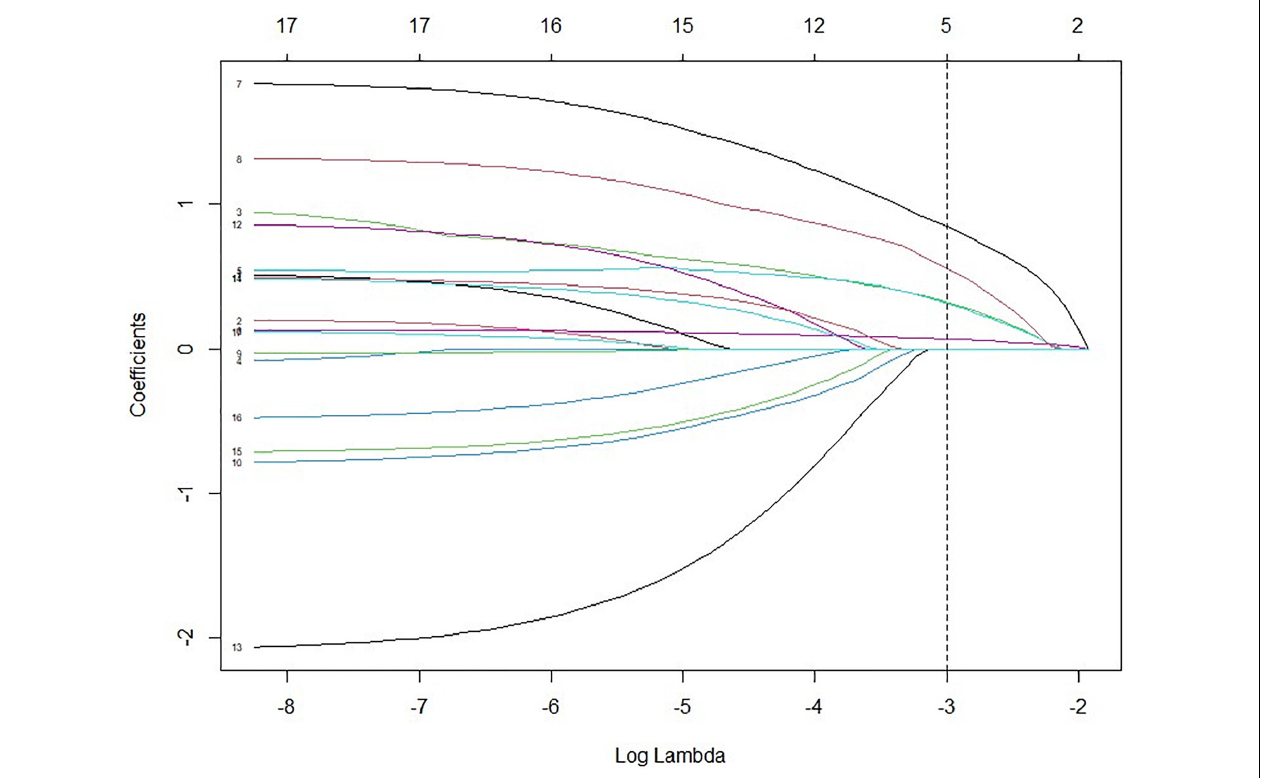
FIGURE 1 | Variables selected by LASSO from 17 characteristics with P < 0.2 from the univariable analysis. (1) Perivascular spaces at basal ganglia; (2) Moderate to severe white matter hyperintensities; (3) ≥ 1 CMBs; (4) CMB location (strict lobe, strict deep, and mixed); (5) cSVD score (0 vs. 1, 2, 3, 4); (6) NIHSS; (7) endovascular therapy; (8) atrial fibrillation; (9) age (per year increase); (10) current smoker; (11) hypertension; (12) ischemic heart disease; (13) prior use of antiplatelet treatment; (14) DWI mode 1 (single, scattered, and multiple); (15) DWI mode 2 (anterior circulation stroke, posterior circulation stroke, and mixed); (16) triglyceride; (17) ASCO stroke subtype. LASSO, least absolute shrinkage and selection operator; ASCO, atherothrombosis, small vessel disease, cardioembolism, other; NIHSS, National Institutes of Health Stroke